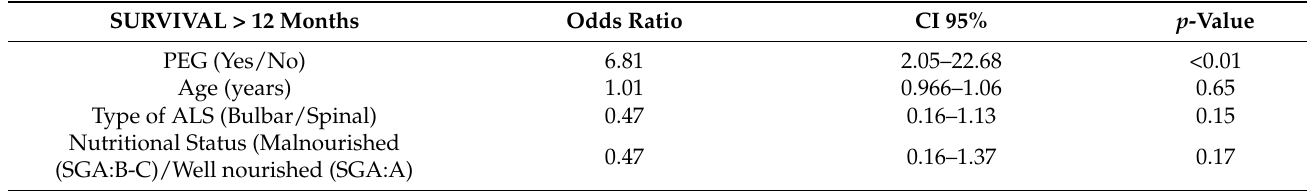
Table 3. Multivariate analysis of the probability of survival over 15 months over variables age, type of ALS, PEG implantation and nutritional status measured by